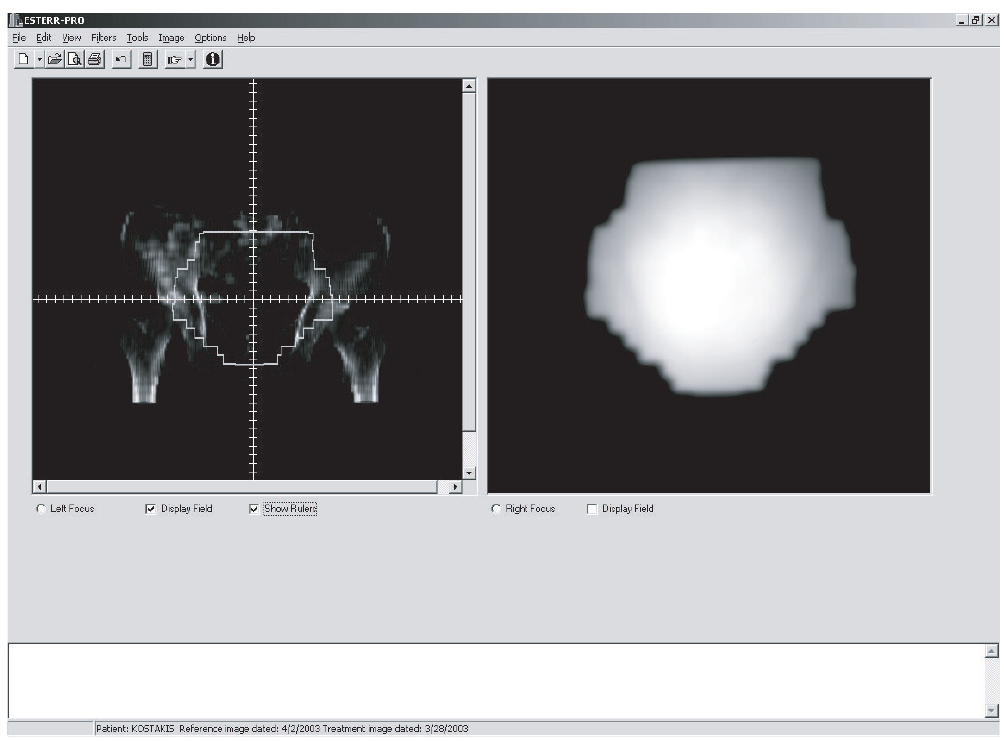
Figure 1: The ESTERR-PRO interface. The main screen is divided into two side-by-side panels. A portal image is displayed on the right panel and a reference image is displayed on the left